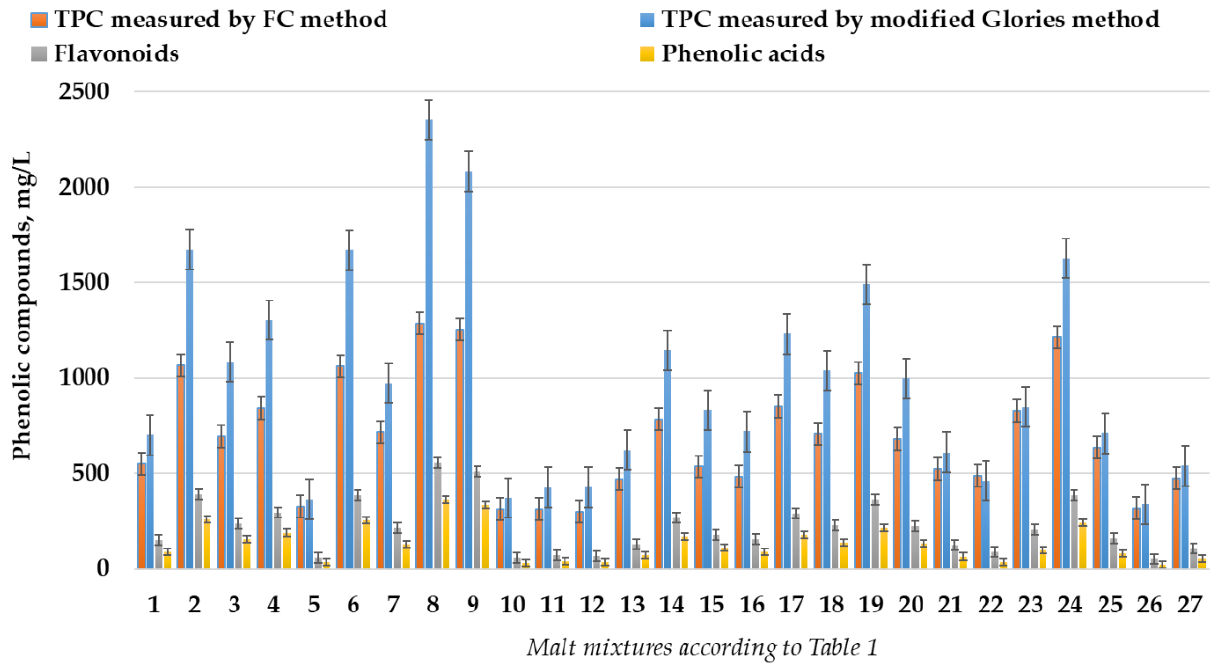
Figure 1. Phenolic compounds content in malt mixtures according to Table 1.